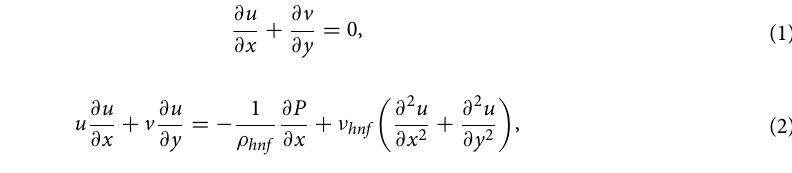
Table 1. The water Prandtl number is specified to be Pr The principal thermophysical characteristics of the base fluid (water) and the added nanoparticles are given in the following Table 1.